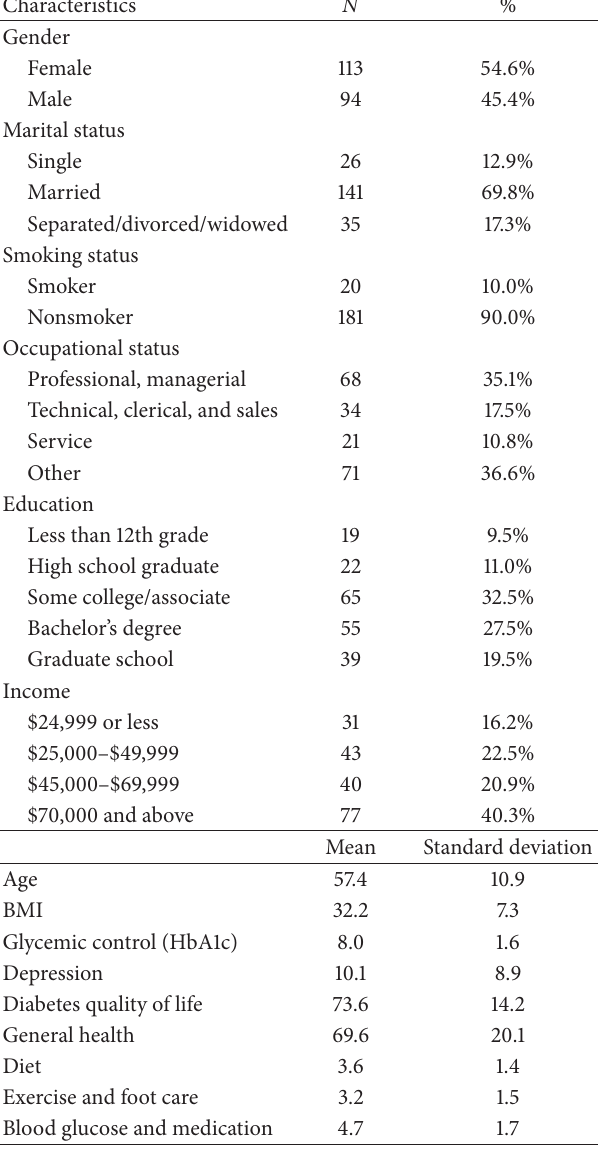
Table 1: Patients’ demographic and clinical characteristics used in the SEM